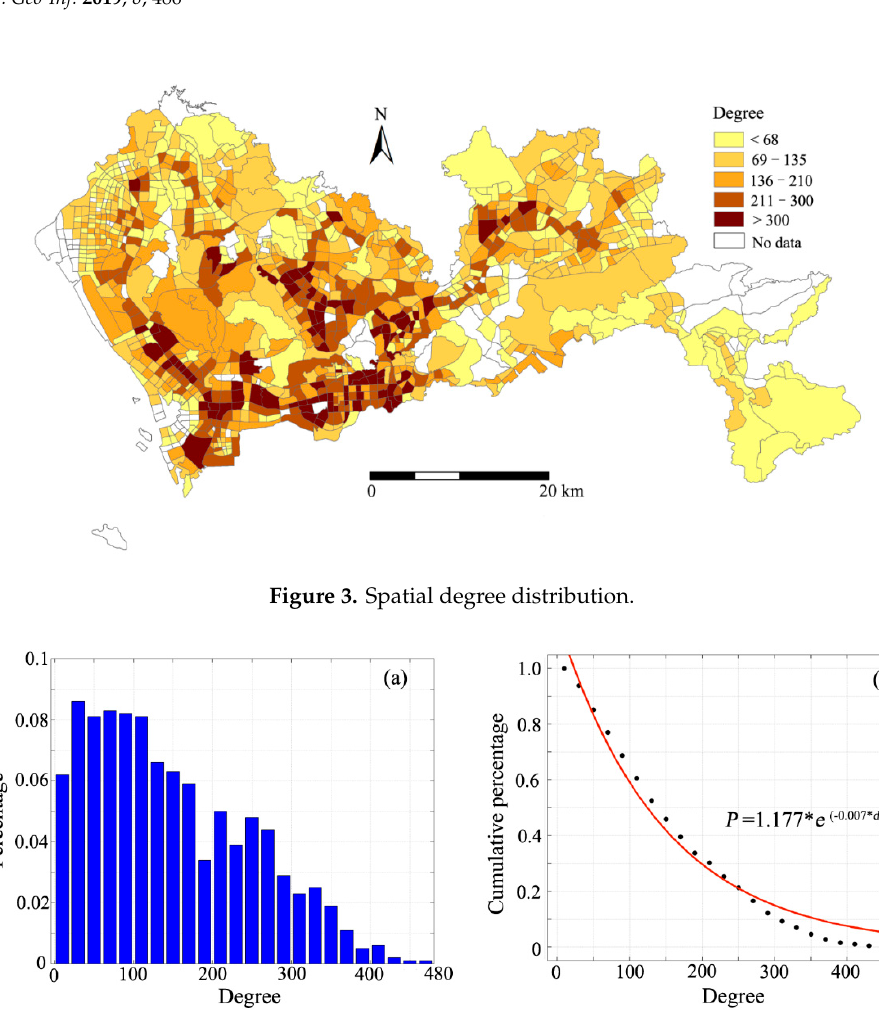
Figure 4. Statistical degree distribution.